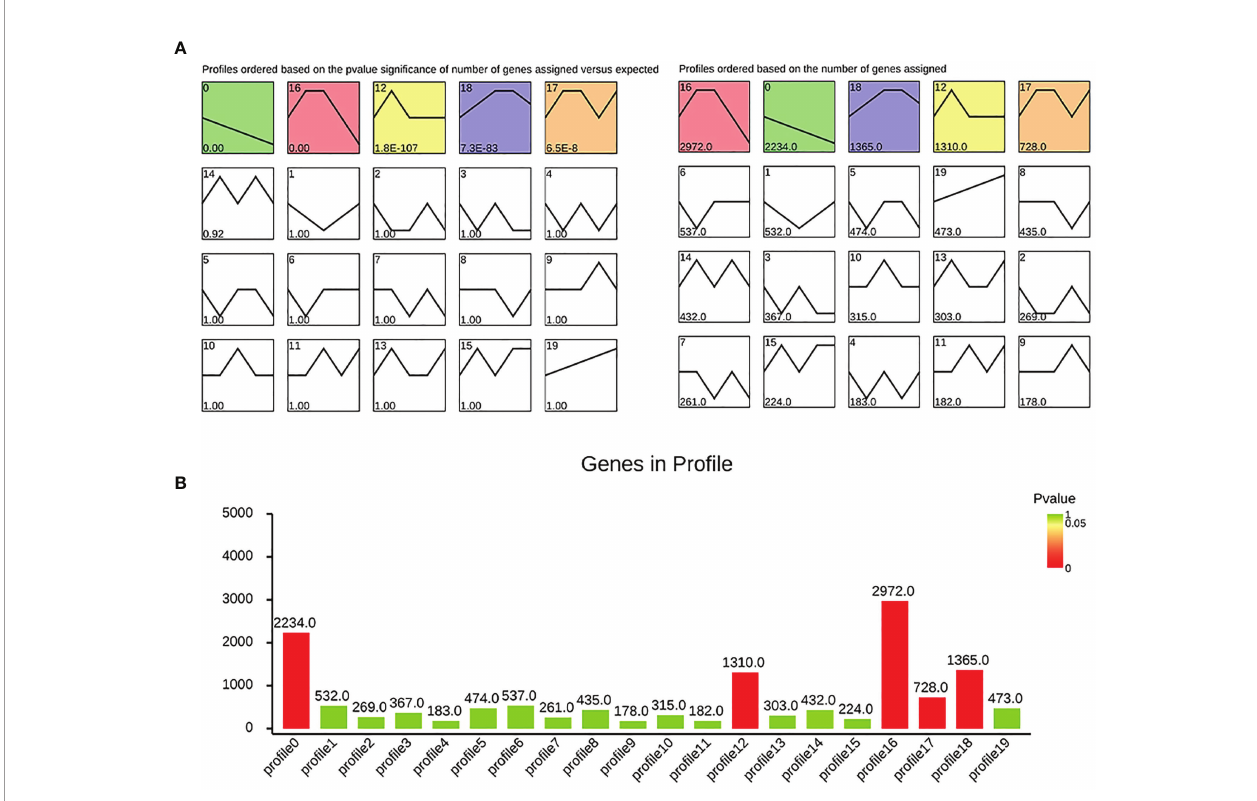
FIGURE 1 | Dynamic trend analysis: (A) the signi fi cance and gene number of each module; (B) histogram showing the situation of each